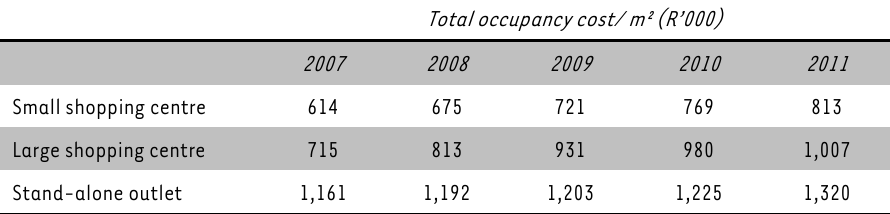
TABLE 5: Total occupancy cost per m²